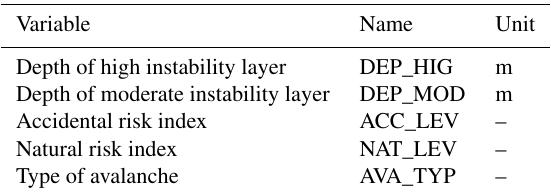
Table 7. List of snowpack stability indices simulated by